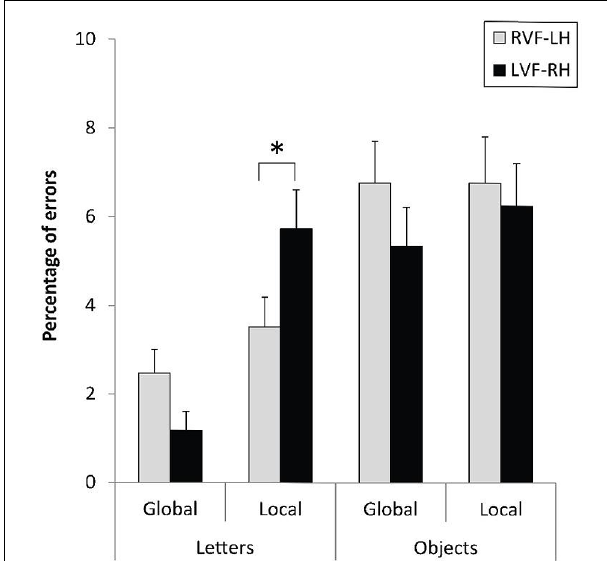
FIGURE 4 | Mean error rates and standard errors for letter-based and object-based hierarchical stimuli displayed to the right (RVF-LH) or left visual field (LVF-RH), as a function of the level of the target (global, local). * p < 0.05.